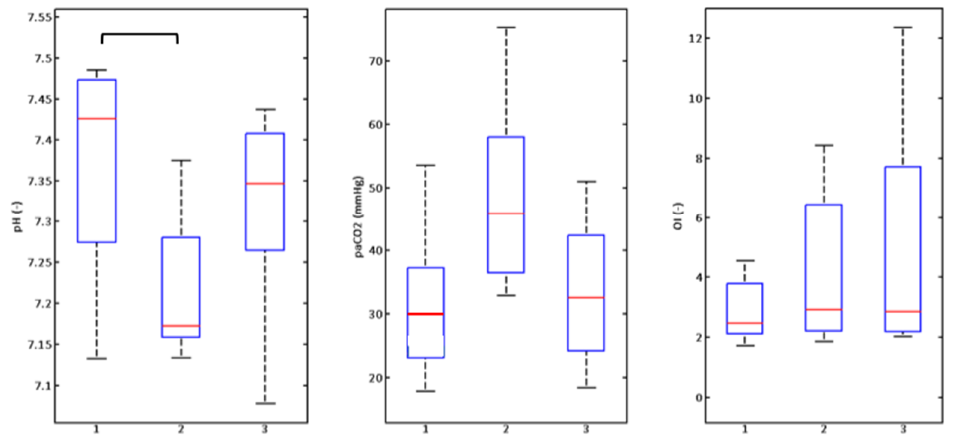
Figure 10. Graphic illustration of monitored parameters of rabbits ( n = 8) at a respiratory rate of 440 breaths/min.